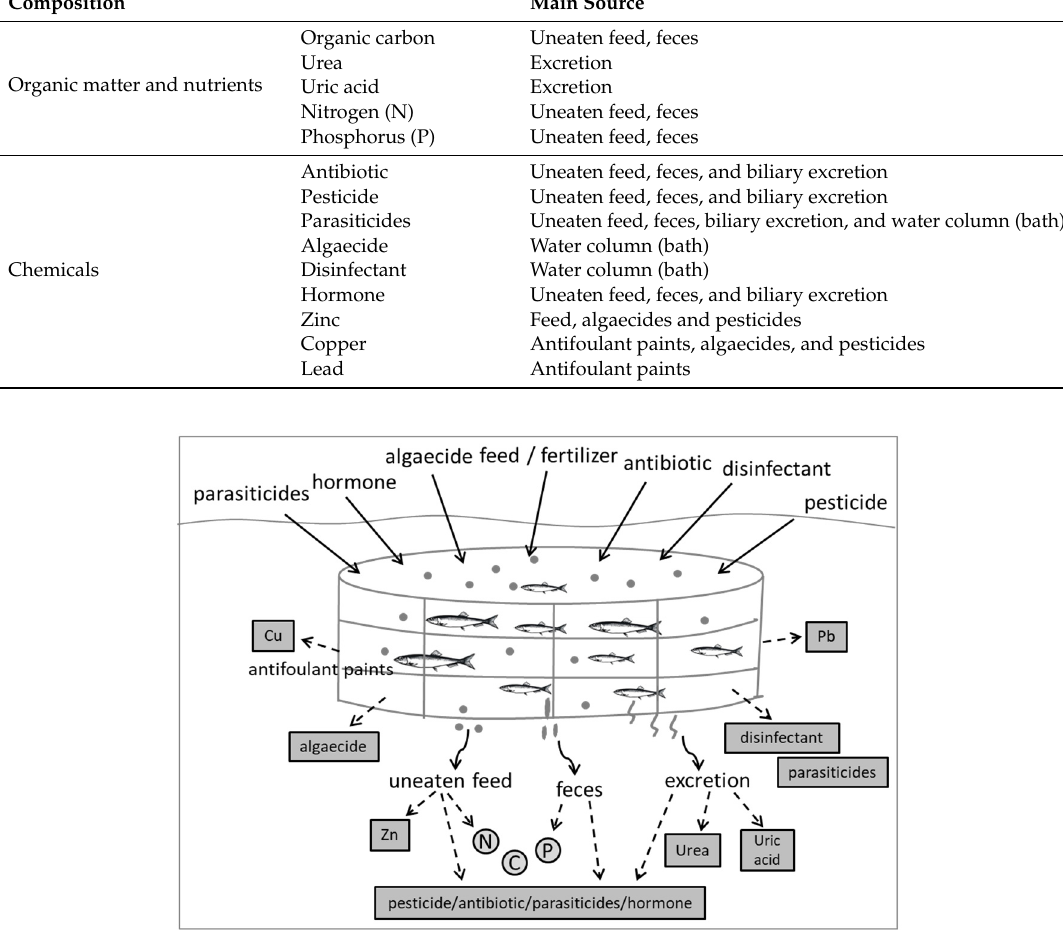
Figure 2. Schematic diagram of mariculture effluent discharge.